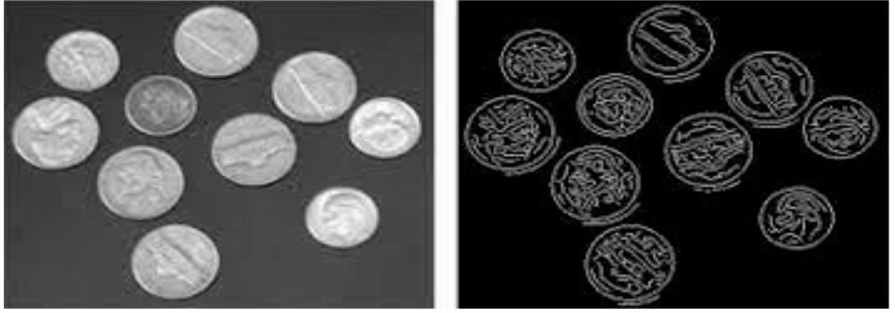
Figure 5. Edge Detection Segmentation